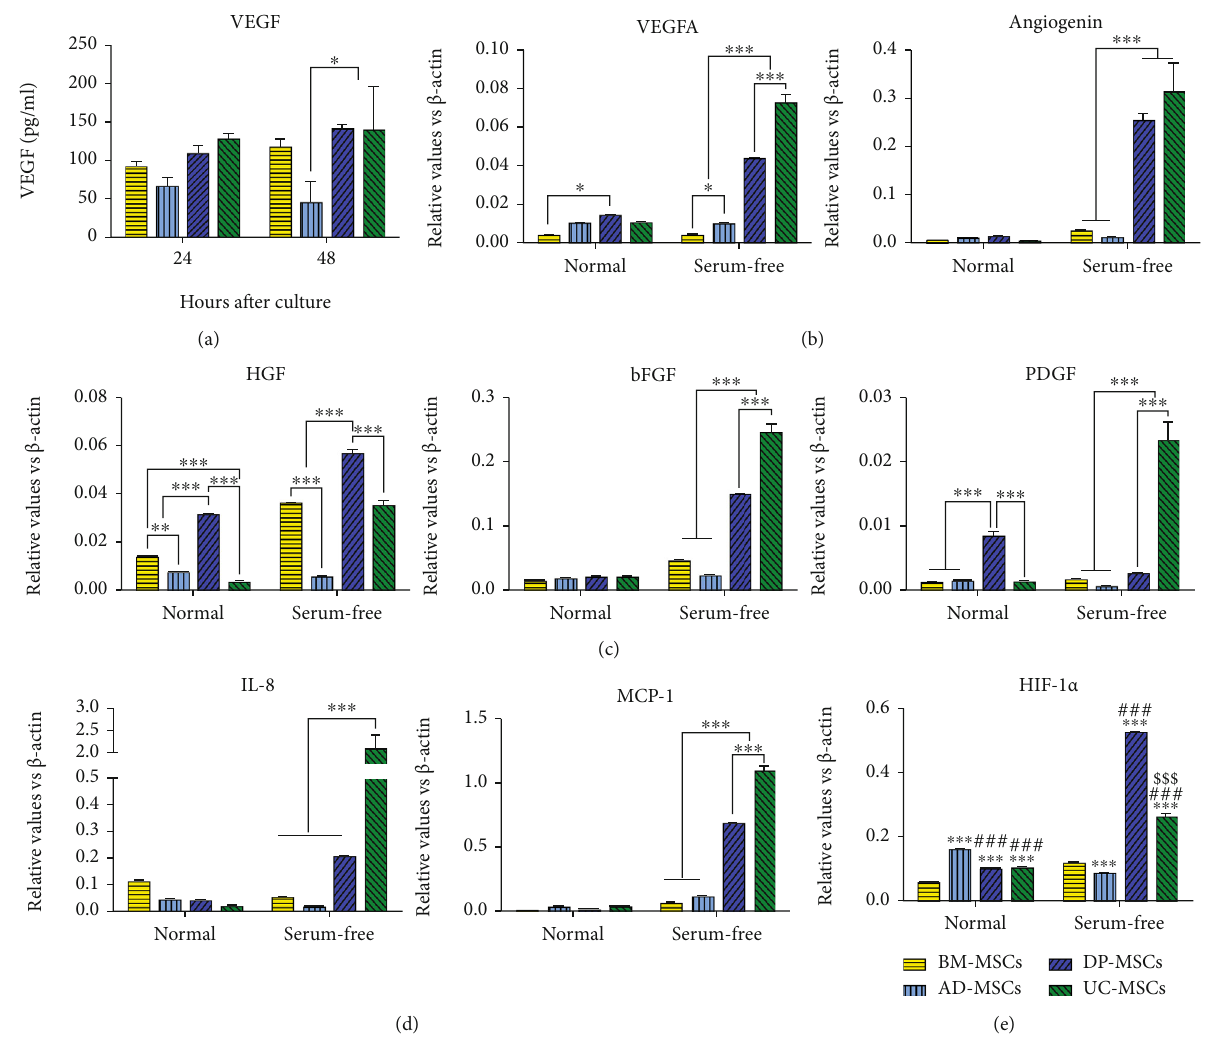
Figure 4: Expression of angiogenic factors in MSCs in normal or serum-free media. BM-MSCs, AD-MSCs, DP-MSCs, and UC-MSCs were seeded in a 6-well plate at a density of 8000 cells per cm 2 and cultured with fetal bovine serum- (FBS-) free α -MEM at 37 ° C and 5% CO culture media were collected at 24 or 48 hours after incubation. And the secretion of vascular endothelial growth factor (VEGF) was detected by ELISA (a). Forty-eight hours after being cultured in α -MEM plus 10% FBS or FBS-free α -MEM, BM-MSCs, AD-MSCs, DP-MSCs, and UC-MSCs were collected. The mRNA expression of angiogenin, basic fi broblast growth factor (bFGF), hepatocyte growth factor, hypoxia- inducible factor-1 α (HIF-1 α ), interleukin-8 (IL-8), monocyte chemotactic protein 1 (MCP-1), platelet-derived growth factor (PDGF), and vascular endothelial growth factor (VEGF) was analyzed by real-time reverse transcription polymerase chain reaction (RT-PCR). The relative expression levels were calculated by the 2 − Δ CT method, using β -actin as the control. Data were shown as mean ± s : e : m . ∗ p < 0 : 05 , ∗∗∗ p < 0 : 001 compared with the corresponding